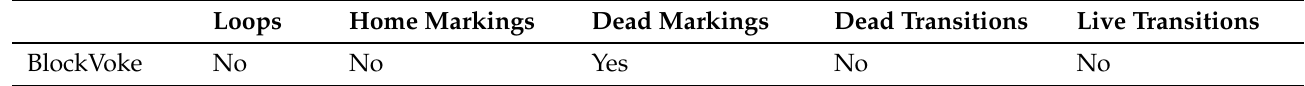
Table 6. Selected state-space analysis results of the BlockVoke CPN model.